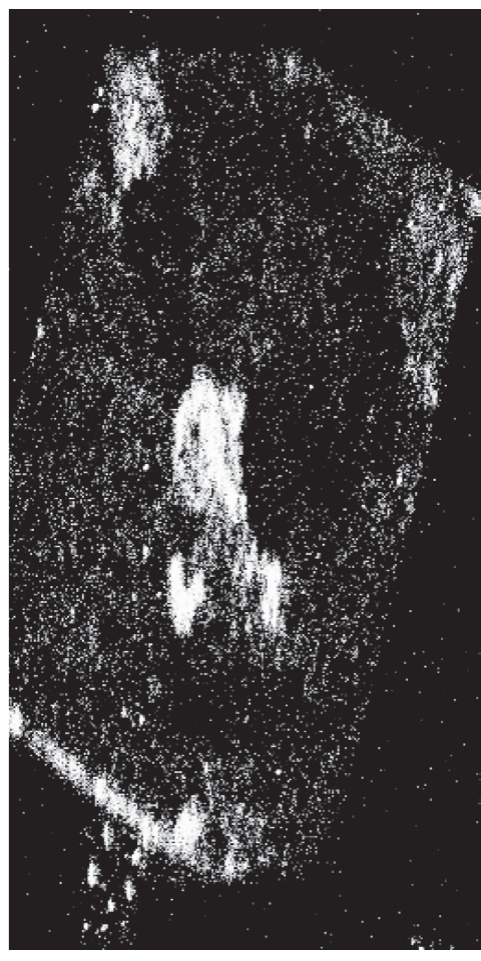
Figure 2. Typical X-ray image obtained with the MAXIM tech- nique.